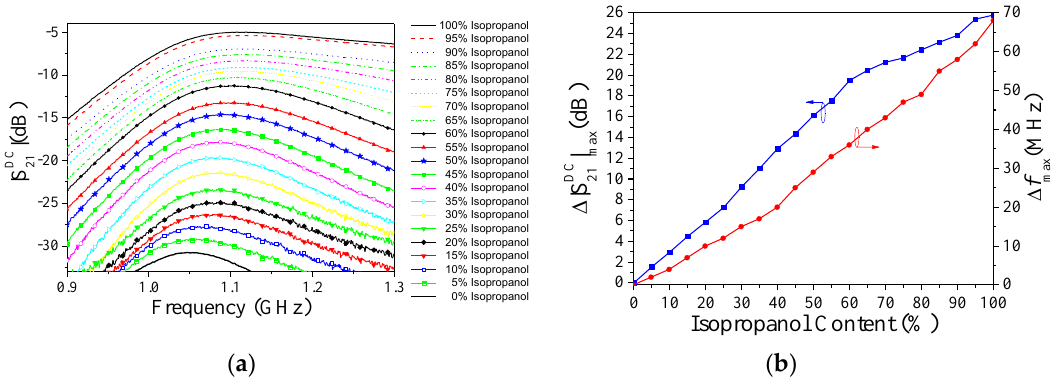
Figure 30. Measured cross-mode transmission coefficients for the different solutions of isopropanol in DI water ( a ) and representation of the output variables as a function of the isopropanol concentration ( b ). From [64], reprinted with permission.